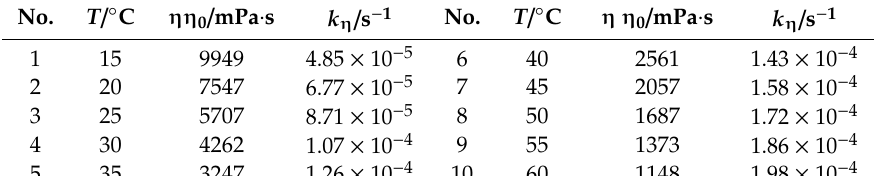
Table 1. Rate constants for viscosity build-up ( k η ) that satisfy the pot life 4 h at di ff erent temperatures.